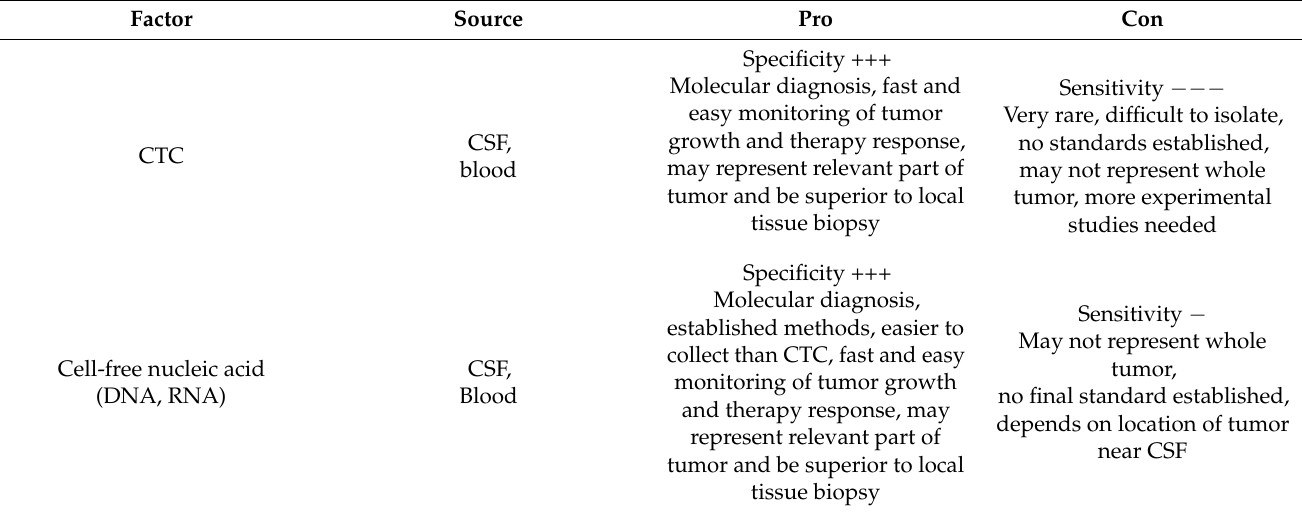
Figure 1. Liquid biopsy. Distant from the original brain tumor, samples from blood and cerebrospinal fluid (CSF) can typically serve as a low-risk source of tumor-derived nucleic acids (RNA, DNA) for further analysis. CSF—cerebrospinal fluid; EV—extracellular vesicle; CTC—circulating tumor cell. Created/modified with https://smart.servier.com (accessed on Table 1. Pros and cons of liquid biopsy in brain tumors.